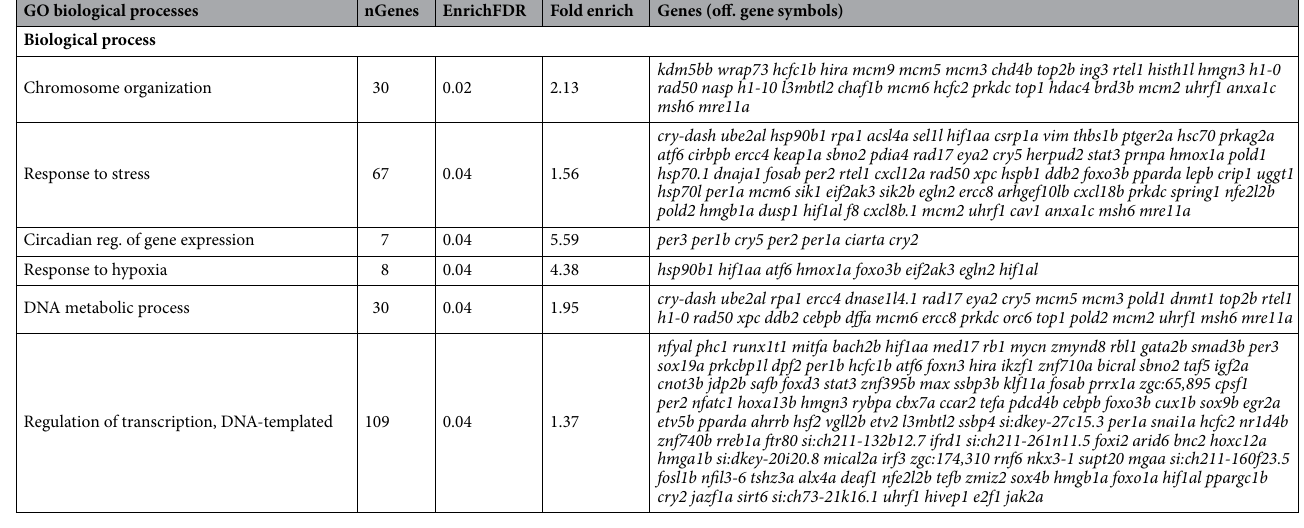
Table 1. Enriched GO (biological processes, cell component, molecular pathways; FDR < 0.05) associated with genes differentially expressed ( p < 0.01) in the haemal region between the normal (N) and recovered (s-L/rec) groups.